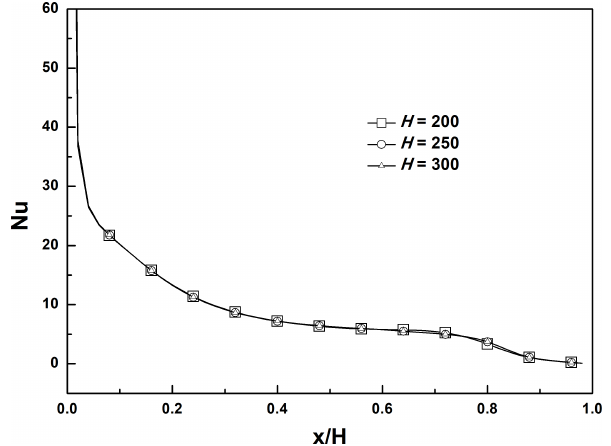
Figure 3. Profiles of Nusselt number along the heated wall for different H values-case